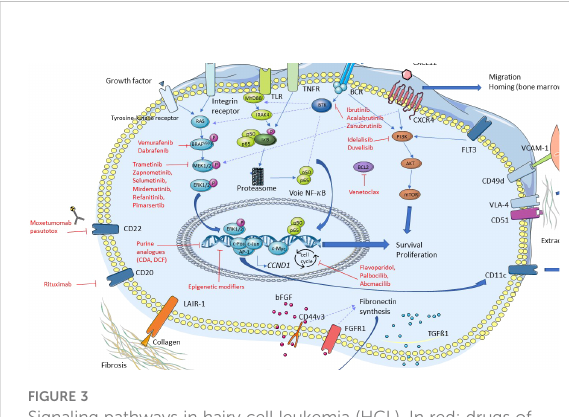
FIGURE 3 Signaling pathways in hairy cell leukemia (HCL). In red: drugs of targetable